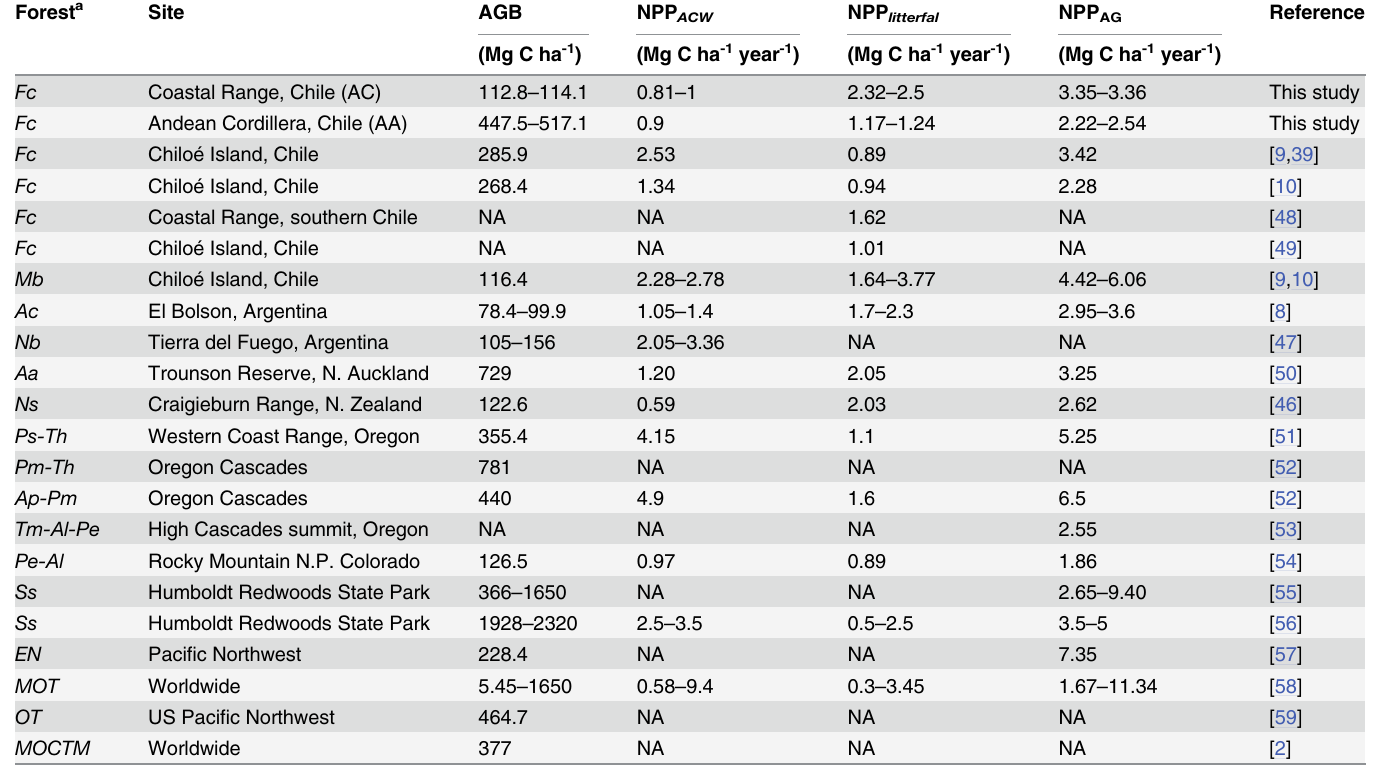
Table 2. Aboveground biomass and productivity in temperate forests